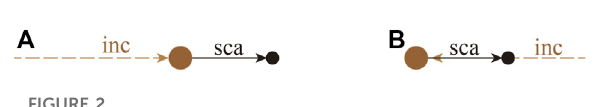
FIGURE 2 Illustration of the bistatic scattering: (A) forward scattering and (B) back